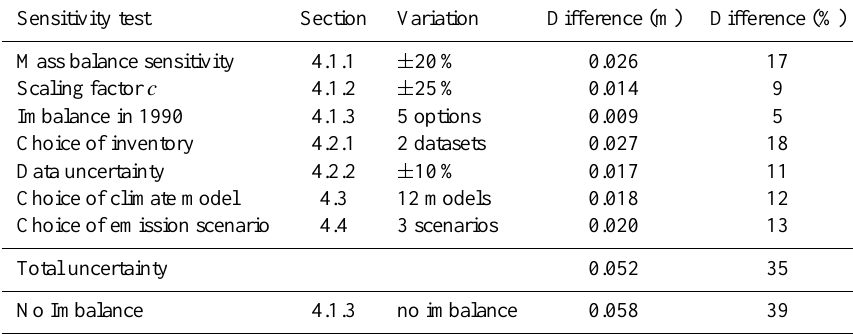
Table 4. Summary of the differences in δV found with the sensitivity